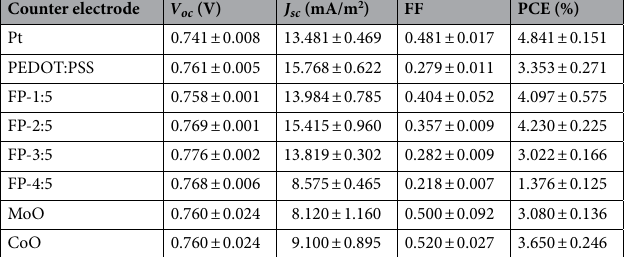
Counter electrode V oc